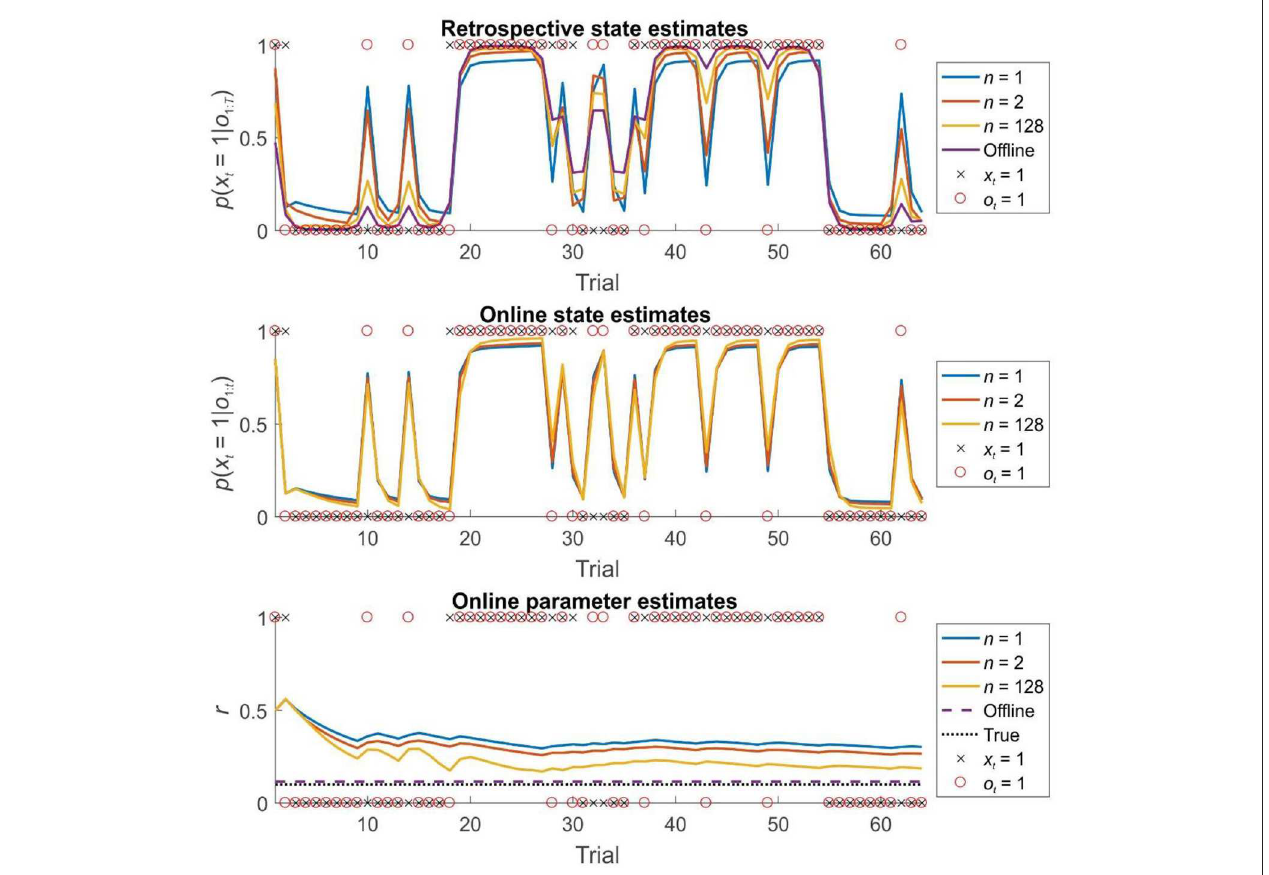
FIGURE 4 | State and parameter estimation for agents performing dual estimation on the first 64 trials of a 256 trial session of the reversal task using different strategies. Top panel: the accuracy of retrospective belief estimates p ( x i | o 1 : T ) increases with greater window lengths, but still falls well-short of the performance of an offline agents, who has access to the entire time series simultaneously. Middle panel: the accuracy of online (filtered) beliefs about the current state p ( x i | o 1 : i ) subtly but consistently increases with greater window length. Note that this effect is entirely due to the beneficial effects of greater window lengths on parameter learning. Bottom panel: the effect of window length on parameter learning. Estimates of r are derived from 5 a at each timestep (the best estimate available to the agent at that time). With greater window lengths, parameter estimates converge more rapidly on the true value (Estimates from agents performing retrospective inference with windows of length 1, 2, and 128 time steps are shown in blue, orange, and gold, respectively. Estimates from an agent performing offline inference is shown in purple. True hidden states are indicated with black crosses, whilst observations are indicated with red circles. The true value of parameter r is indicated with a dotted black line in